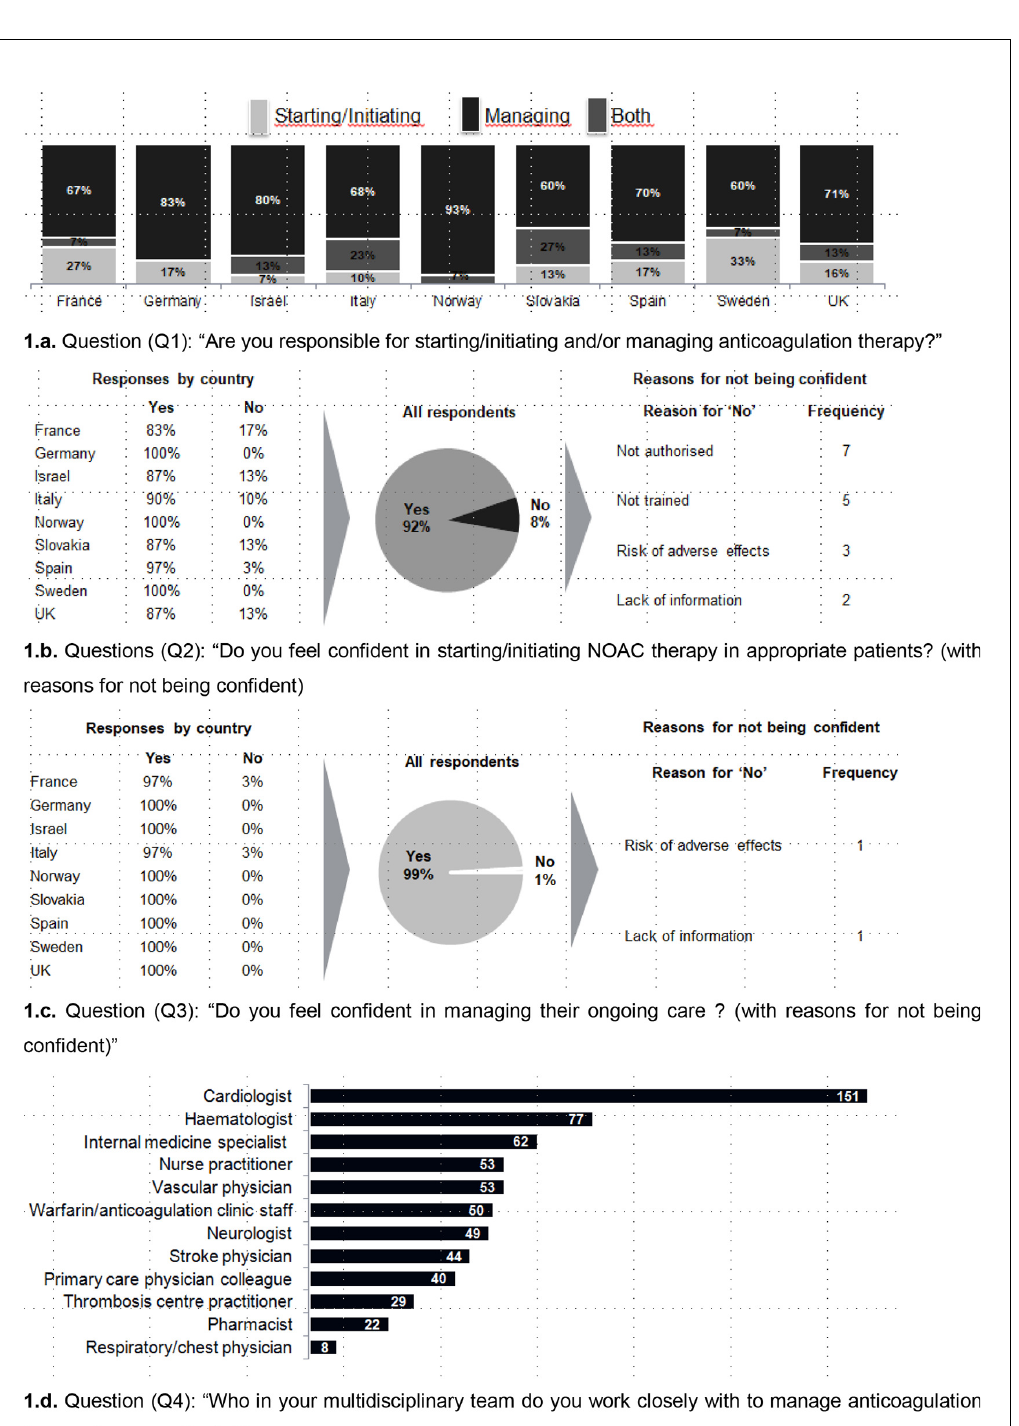
Figure 1. Responsibility and confidence in initiation and ongoing management of NOACs NOAC = non-vitamin K antagonist oral anticoagulant. VKA = vitamin K